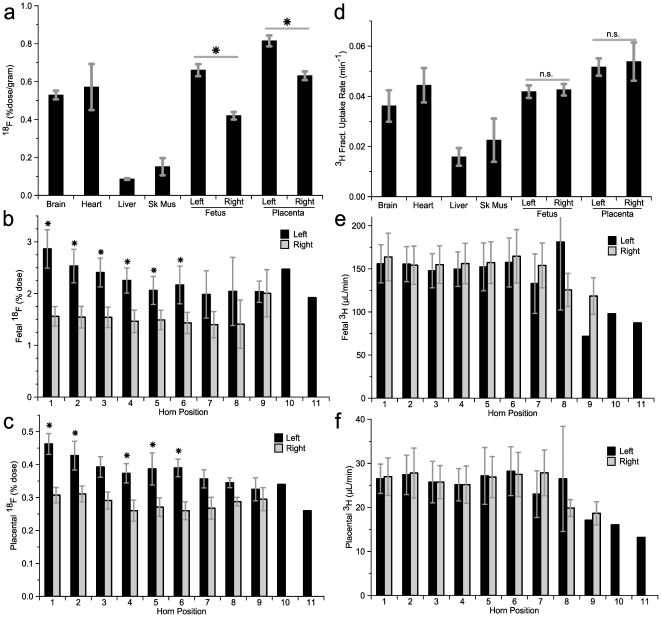
Final accumulation of glucose tracers.(a) Per gram accumulation of 18F in various tissues at 160 minutes after FDG infusion. (* p<10−5 for left versus right, n = 76–79). Per fetus (b) and per placenta (c) accumulation of 18F, based on uterine horn position. The fetus/placenta closed to the cervix is counted as position 1. * p<0.05 left versus right. (d) Clearance of 3H into various tissues as measured after completion of the scan (n.s. not significant for left versus right). Per fetus (e) and per placenta (f) accumulation of 3H, based on uterine horn position.